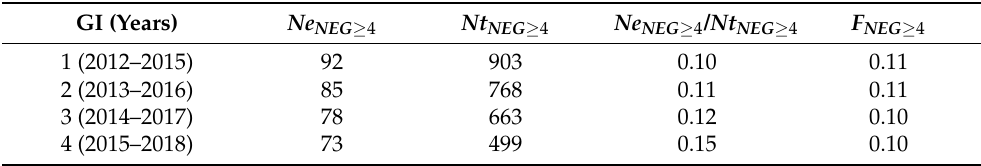
Table 7. Estimated effective population size and coefficient of inbreeding in recent populations (animals with NEG >